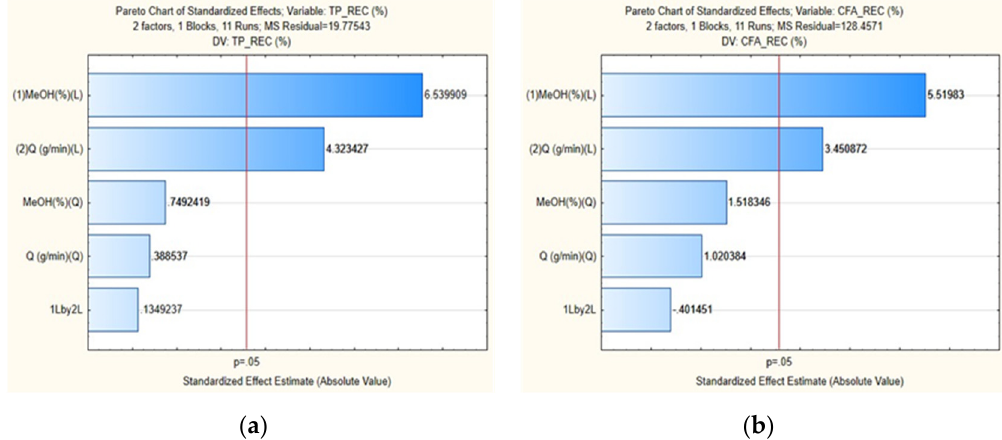
Figure 1. Pareto chart of effects for both responses of the optimization study for the SFE of potato peels: TPR ( a ) and CFA recovery ( b ).